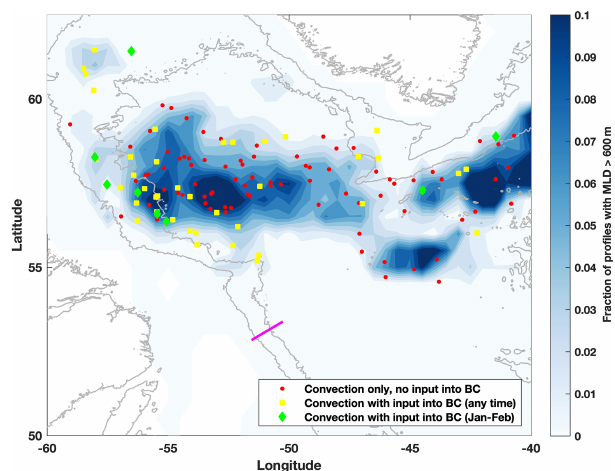
Figure 7. Fraction of total profiles from Holte et al. (2017) database with mixed layer depth (MLD) over 600m. Grey contours show the 2000 and 3000m isobaths, and the magenta line shows the 53 ◦ N array. Overlaid are the convection locations for each float measuring convection as defined in Sect. 2.3, differentiating between floats that are not found in the boundary current within the same year (red dots), those that do enter the boundary current (yellow squares), and those that are found in the boundary current in either January or February (green diamonds).